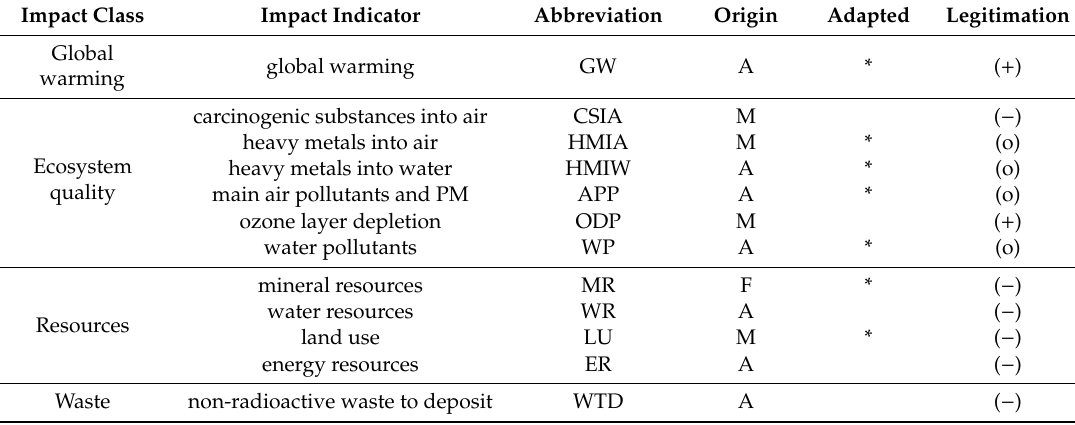
Table 1. ENsource ESM impact indicators. Origin: indicates ESM from which indicator was adopted: A = Ahbe et al. [17], M = Muhl et al. [21], F = Frischknecht and Büsser-Knöpfel [13]. Adapted: Asterisks (*) indicate adaptations of target value T with respect to original ESM. Legitimation: Di ff erent categories: ( + ) high (e.g., law, regulation); (o) medium (e.g., binding international treaty, EU directives); ( − ) low (e.g., derived from qualitative goals,